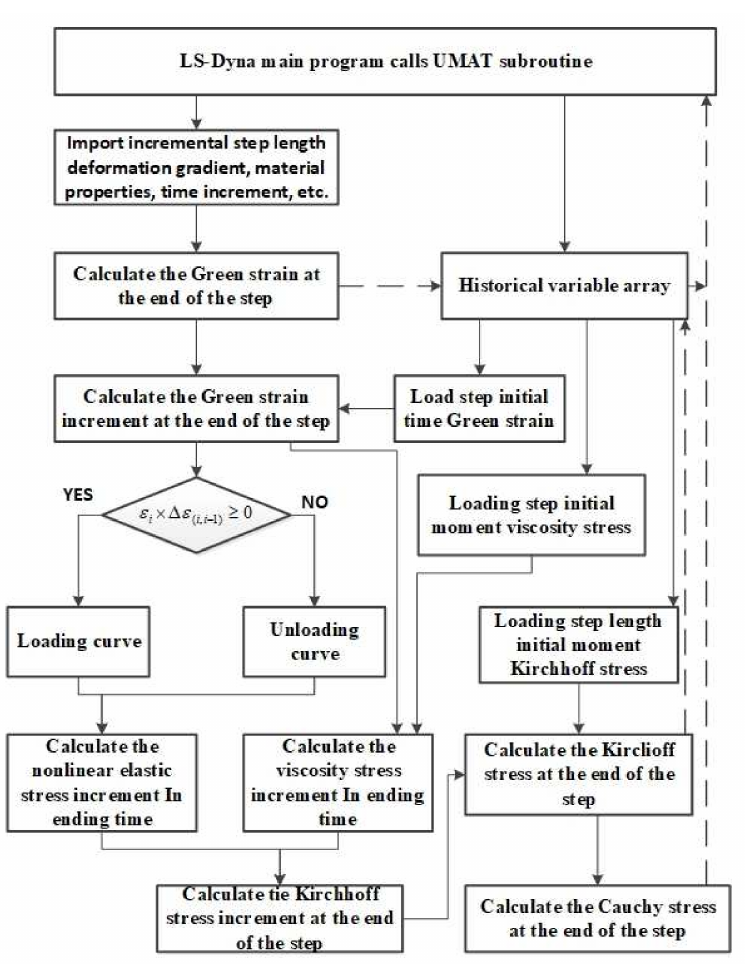
Figure 11. Calculation flow of user-defined subroutine for damping alloy material.